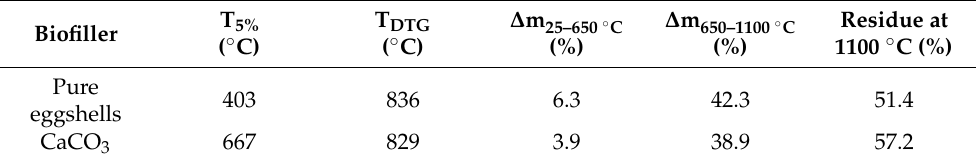
Figure 3. Thermogravimetric (TG) and derivative thermogravimetric (DTG) curves of the ground eggshells and CaCO 3 . ( a ) TG curves; ( b ) DTG curves. Table 3. Onset temperature of thermal decomposition (T 5% ), DTG peak temperature (T DTG ), and total mass loss (∆m) during decomposition of pure eggshells and CaCO 3 (SD: T 5% ± 1.3 °C; T DTG ± 1.2 °C; ∆m ± 1.2%).